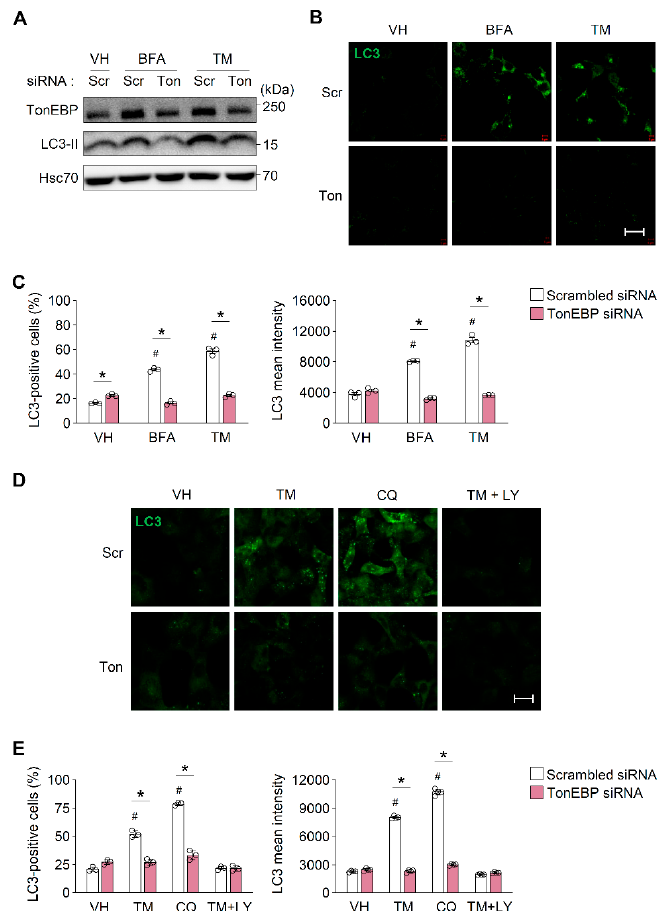
Figure 2. TonEBP promotes autophagy in pancreatic β cells. ( A ) MIN6-M9 cells transfected with scrambled siRNA (scr) or TonEBP-targeted siRNA (Ton) were treated for 6 h with vehicle (VH), brefeldin A (BFA; 20 µ M), or tunicamycin (TM; 1 µ g / mL). TonEBP, LC3-II, and Hsc70 were